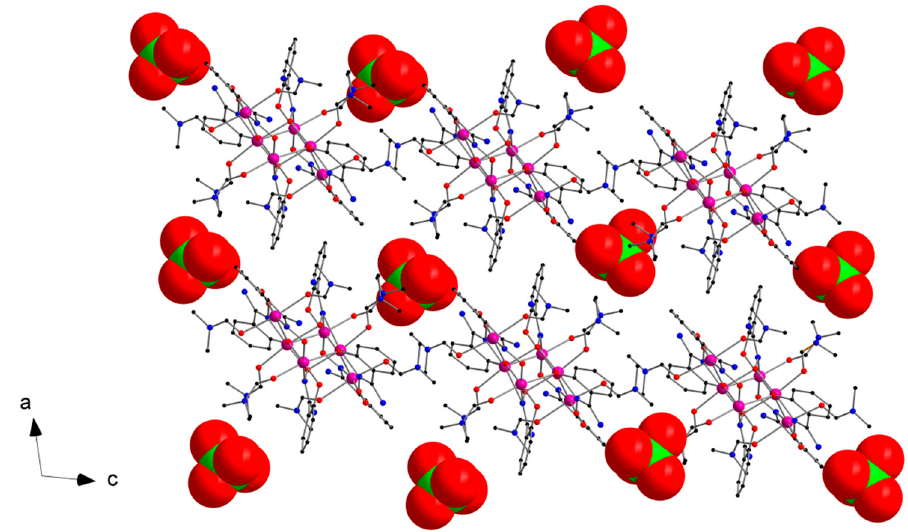
Figure 3. View along the crystallographic b axis of a fragment of the packing of 1 showing the arrangement of the [Mn 6 ] 2+ cations and (ClO 4 ) − anions (space-filling model). H atoms have been omitted for clarity. Colour code: Pink, Mn; red, O; blue, N; black, C; green, Cl.